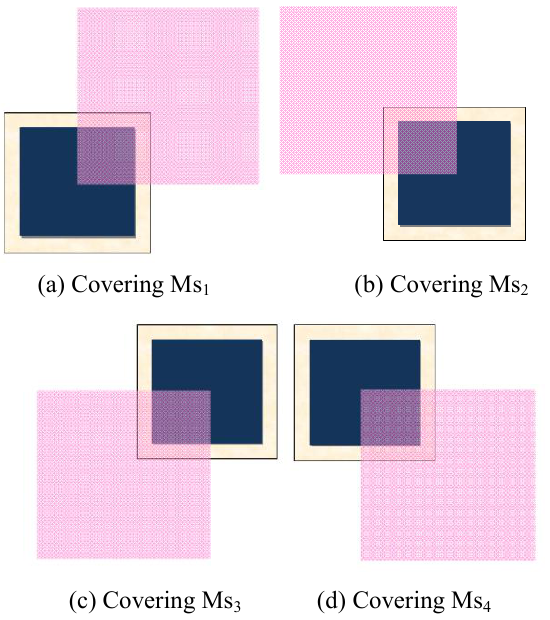
Figure 7. Manipulation of radiation pattern by covering Magnetic Sources.